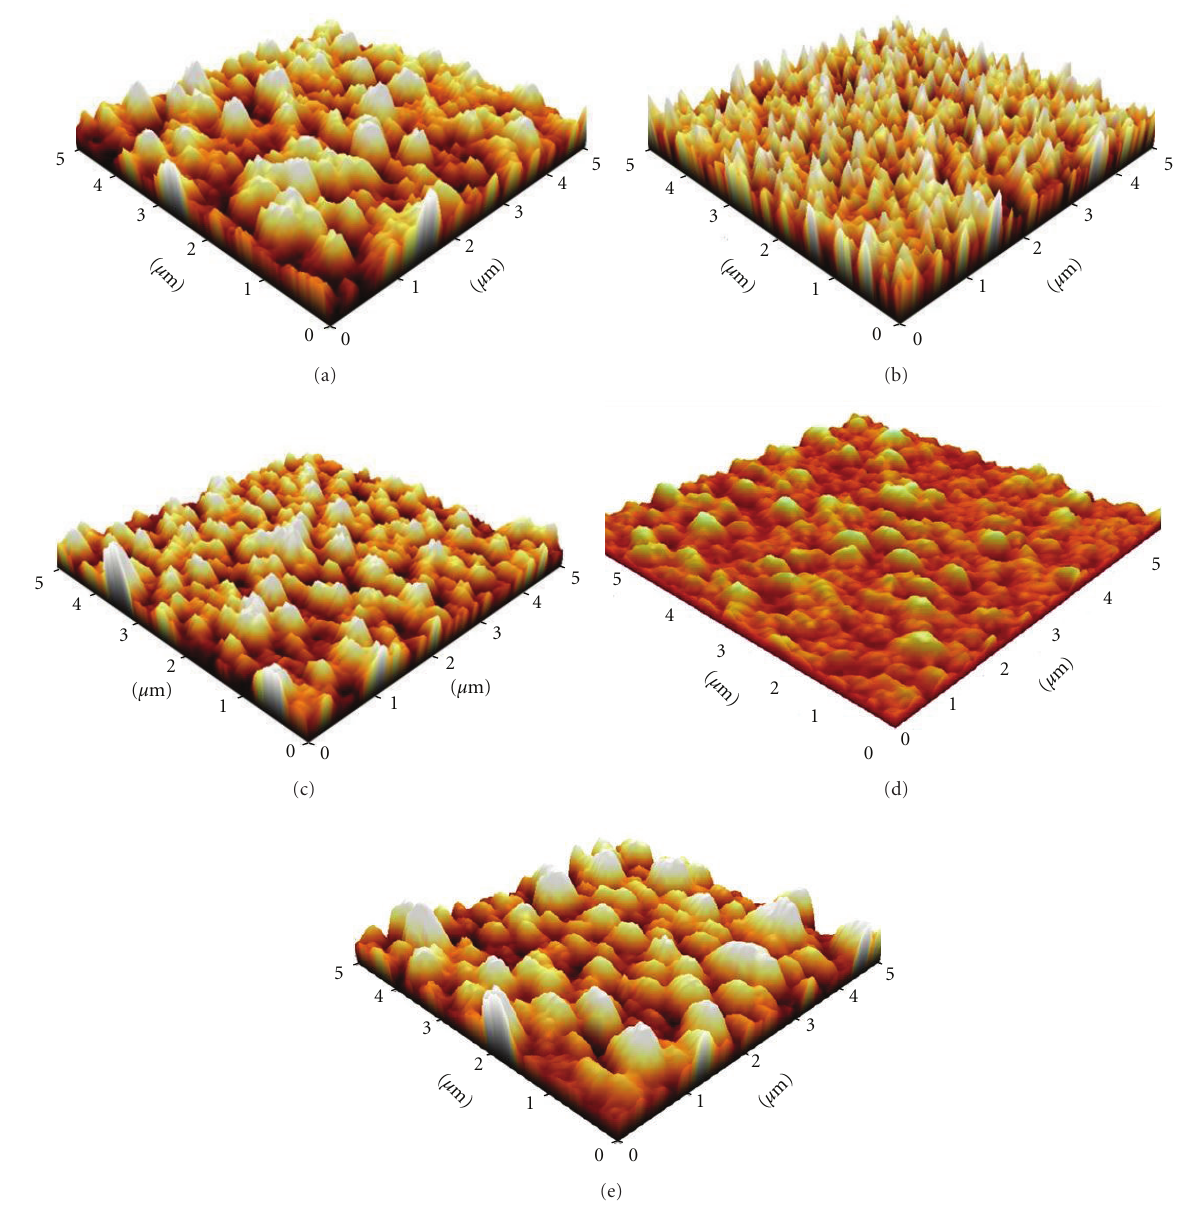
Figure 4: AFM morphologies of the ITiO film at di ff erent RF powers. (a) 220 W, (b) 250 W, (c) 280 W, (d) 300 W, (e)